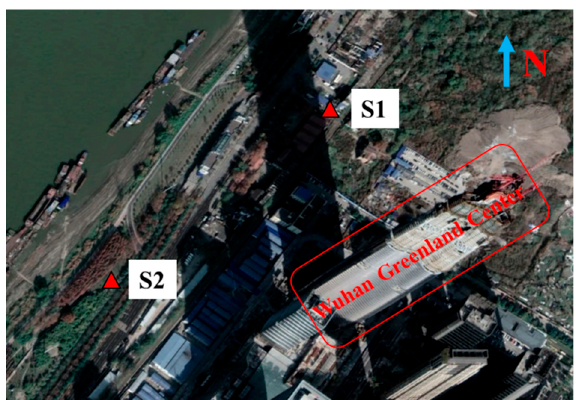
Figure 3. Distribution map of the two IBIS-S system installation locations (S1 and S2). The red triangle denotes the location of the IBIS-S system, and the monitored object (i.e., the WGC) is outlined by a red rectangle.